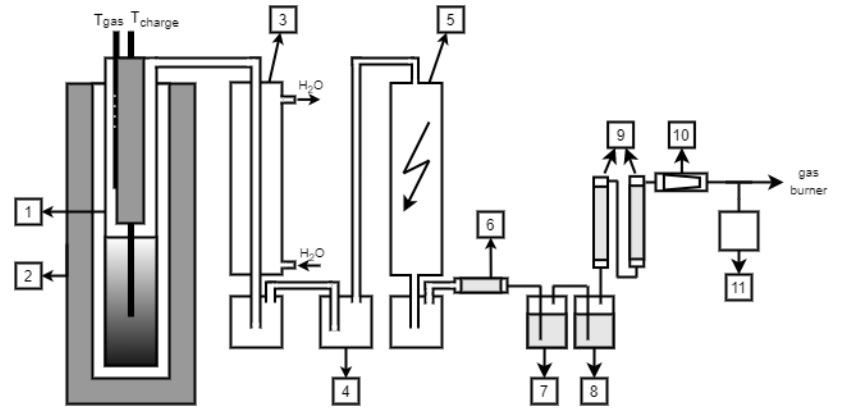
Figure 1. A schematic diagram of the Karbotest laboratory plant coking process. ( 1 ) Retort, ( 2 ) furnace, ( 3 ) water cooler, ( 4 ) pyrolysis gas pressure regulator, ( 5 ) electrostatic precipitator, ( 6 ) filter, ( 7 ) scrubber with H 2 SO 4 , ( 8 ) scrubber with KOH, ( 9 ) BTX adsorbers, ( 10 ) gas meter, and ( 11 ) gas sample container.